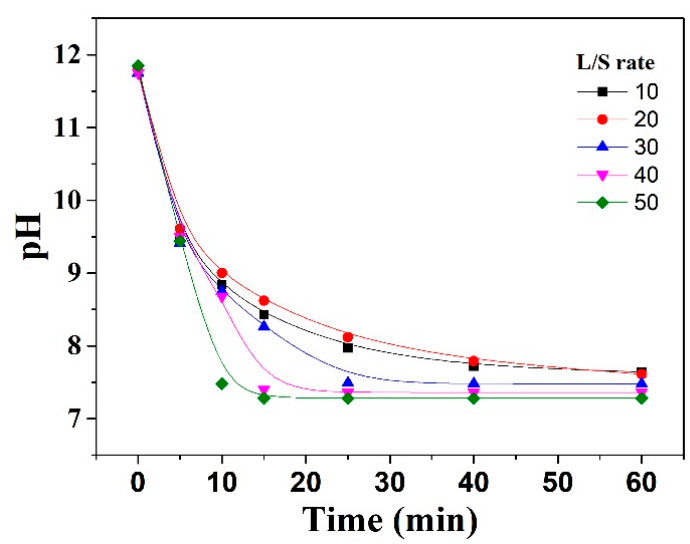
Figure 7. Variation of pH as a function of time.